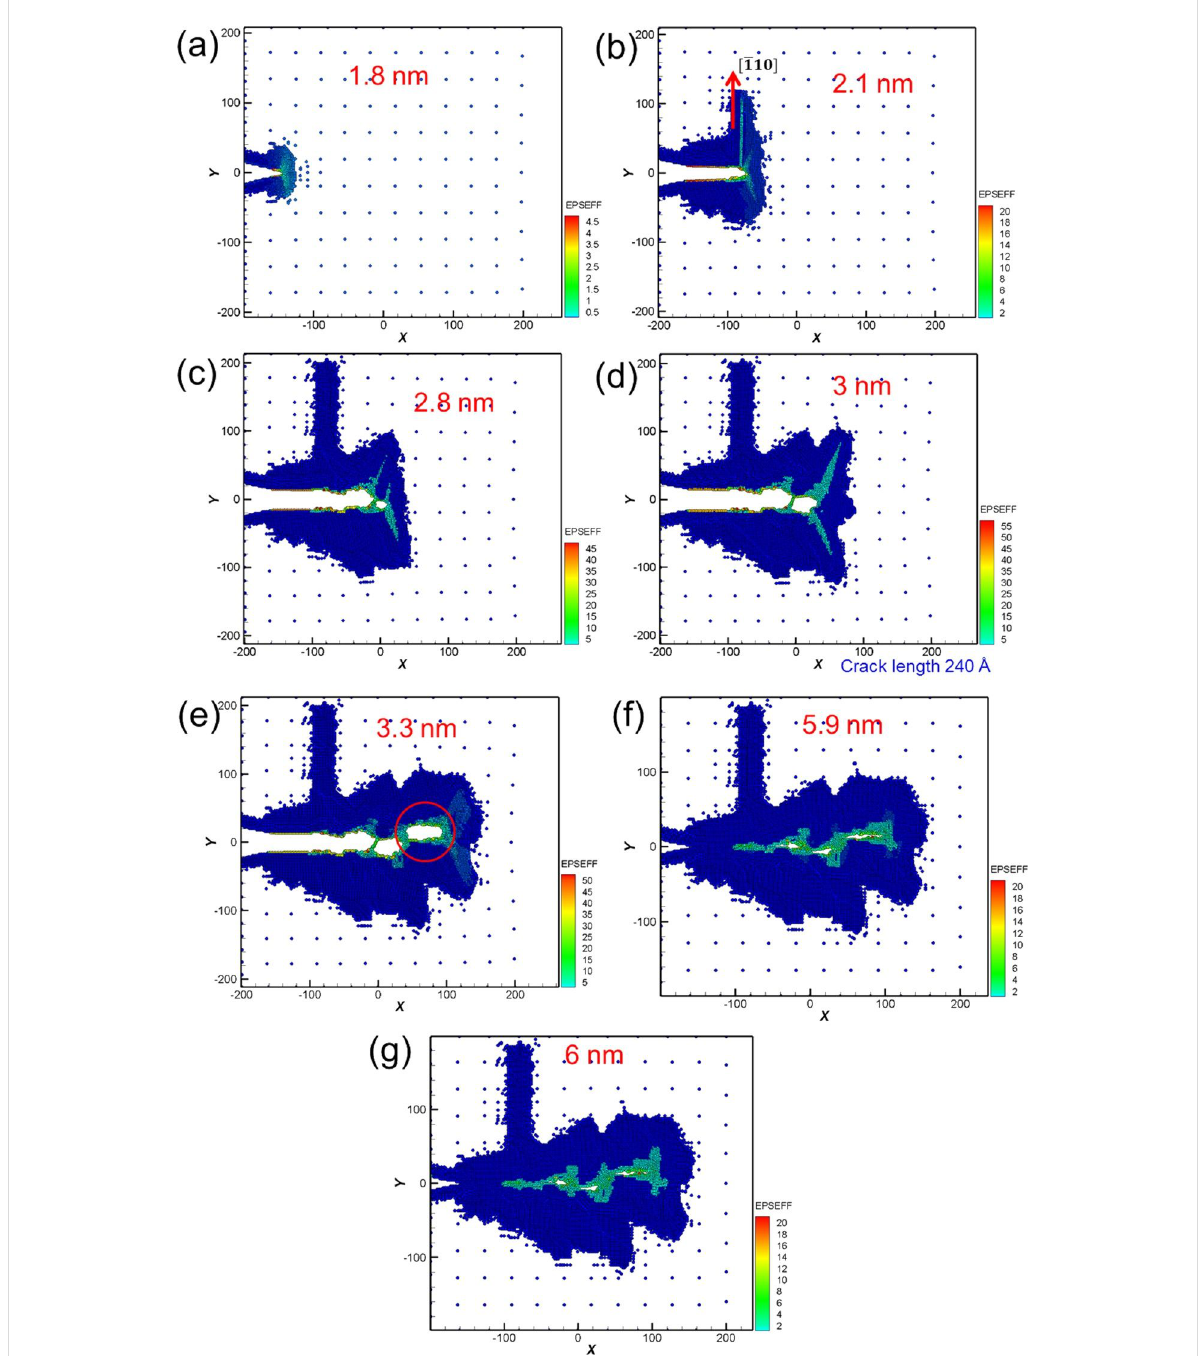
Figure 8: Crack growth and expansion diagrams of Fe under the first cyclic loading at different moving distances. The crack length is 240 Å at a tension distance of 3 nm.